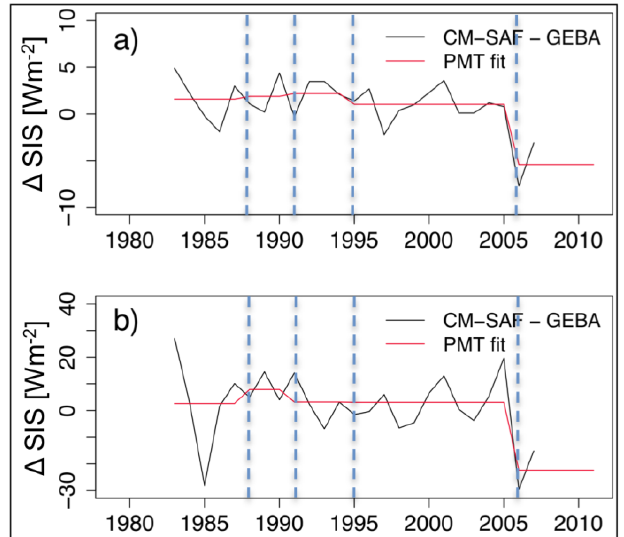
Figure 7. Monthly CM SAF minus GEBA series for the station Aberporth including the PMT fit of the RH test (red line), for: ( a ) January, and ( b ) July. Breakpoints are indicated by dashed